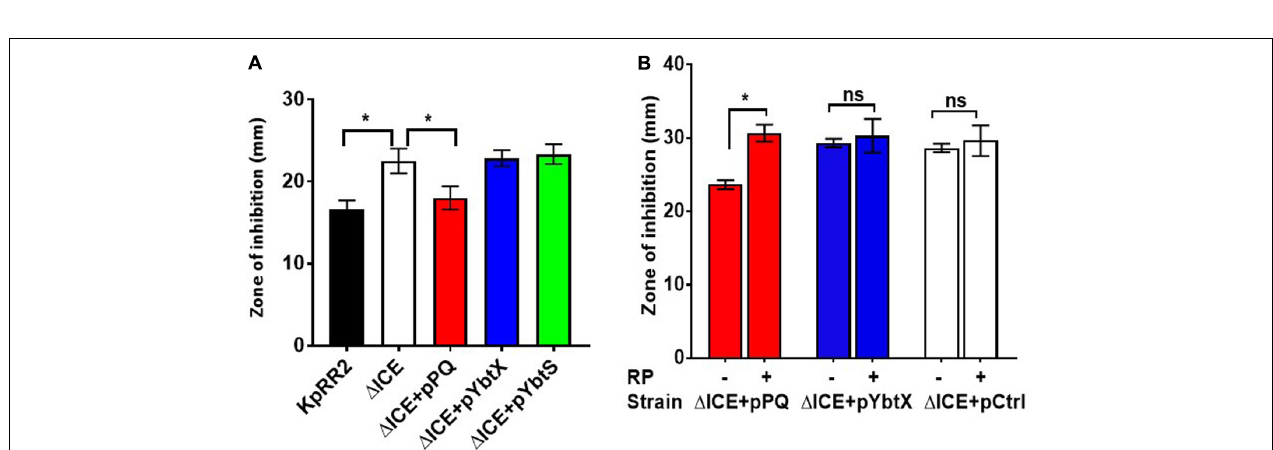
FIGURE 4 | Efflux pump inhibitor reserpine increased the susceptibility of K. pneumoniae , but not the ICEKp knockout, to antimicrobials. Addition of reserpine (RP, 50 µ g/ml) significantly increased the diameter of the zone of inhibition of study strain KpRR2 and the plasmid-complemented mutant (cid:49) ICE + pSXPQA for trimethoprim (A) and tetracycline (B) . By contrast, the presence (+) or absence (-) of reserpine had no significant effect on the zones of inhibition of the knockout strain (cid:49) ICE. Trimethoprim was used at 5 µ g per disk and tetracycline at 25 µ g per disk. Data are the mean and standard deviation of three replicates. *indicates p < 0.05 using Student’s t test. “ns” indicates p > 0.05. The assay was also performed with other antimicrobials giving similar results ( Supplementary Figure 1 ).